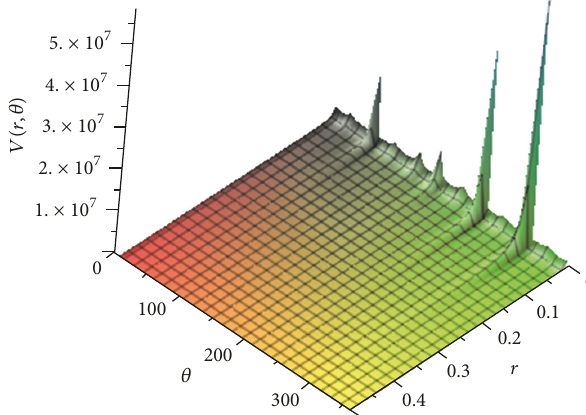
Figure 1: The plot of the novel P¨oschl-Teller plus ring-shaped potential as a function of 𝑟 and 𝜃 for 𝐴 = 1 , 𝐵 = 2 , 𝜆 = 0 . 1 , 𝛾 = 2 , 𝜍 = 4 , and 𝜅 = 3